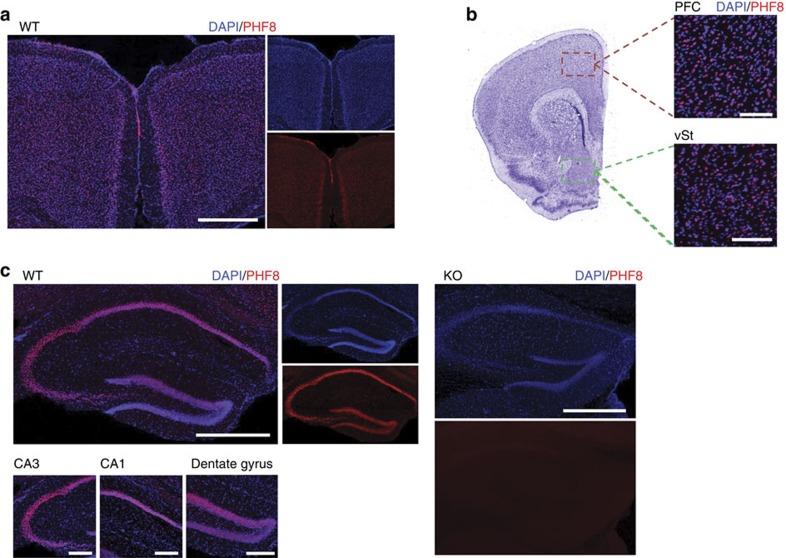
Characterization of Phf8 expression in brain regions relevant to anxiety and depression.(a) PHF8 expression (red) in the neocortex. Note that PHF8 is most strongly expressed in layer V, although it is also detectable in layers II/III. Scale bar, 500 μm. (b) Expression of PHF8 in the prefrontal cortex (PFC) and ventral striatum (vSt) Scale bar, 100 μm. (c) PHF8 expression in the dorsal hippocampus of WT (left) mice, no signal is detected in the KO control (right). PHF8 appears broadly expressed throughout the hippocampus. Top scale bar (whole hippocampus), 500 μm. Bottom scale bar (CA3, CA1, DG), 200 μm.